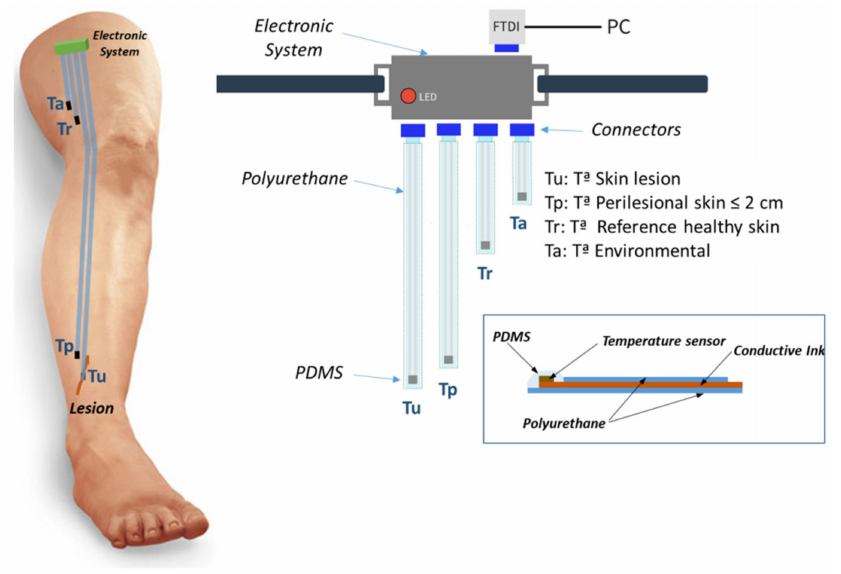
Figure 1. Sensor system configuration: the electronic measurement, data storage, and transmission system are attached to the leg by means of an extensible tape. The different temperature sensors placed in the areas detailed in the figure are connected to this system. The entire sensor system is covered with a compression bandage (not shown in the figure).